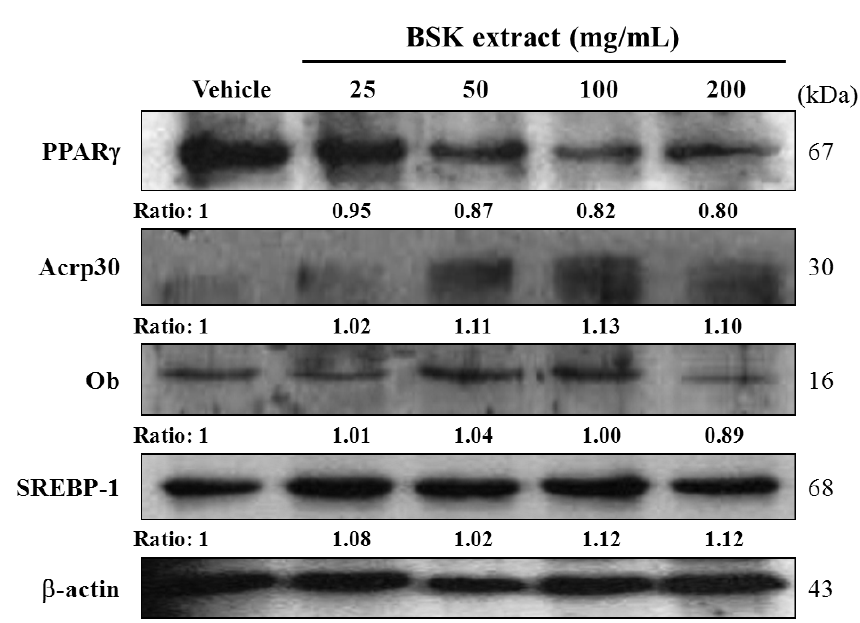
Figure 3. Western blot analysis of the effect of BSK extract on protein expression of PPARγ, Acrp30, Ob and SREBP-1 on day 8 in 3T3-L1 preadipocytes.